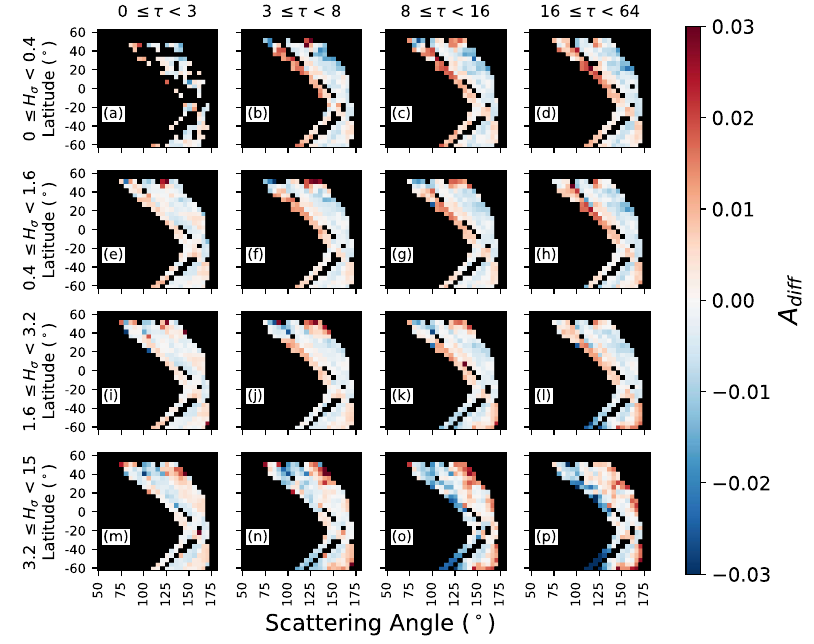
Figure 6. The median A diff values for ranges of cloud optical thickness as a function of cloud heterogeneity index ( H σ ) on December solstices from 2012 to 2015 stratified by (from left to right) cloud optical thickness bins of 0–3, 3–8, 8–16, and 16–64; and (from top to bottom) H σ bins of 0–0.4, 0.4–1.6, 1.6–3.2, and 3.2–15.